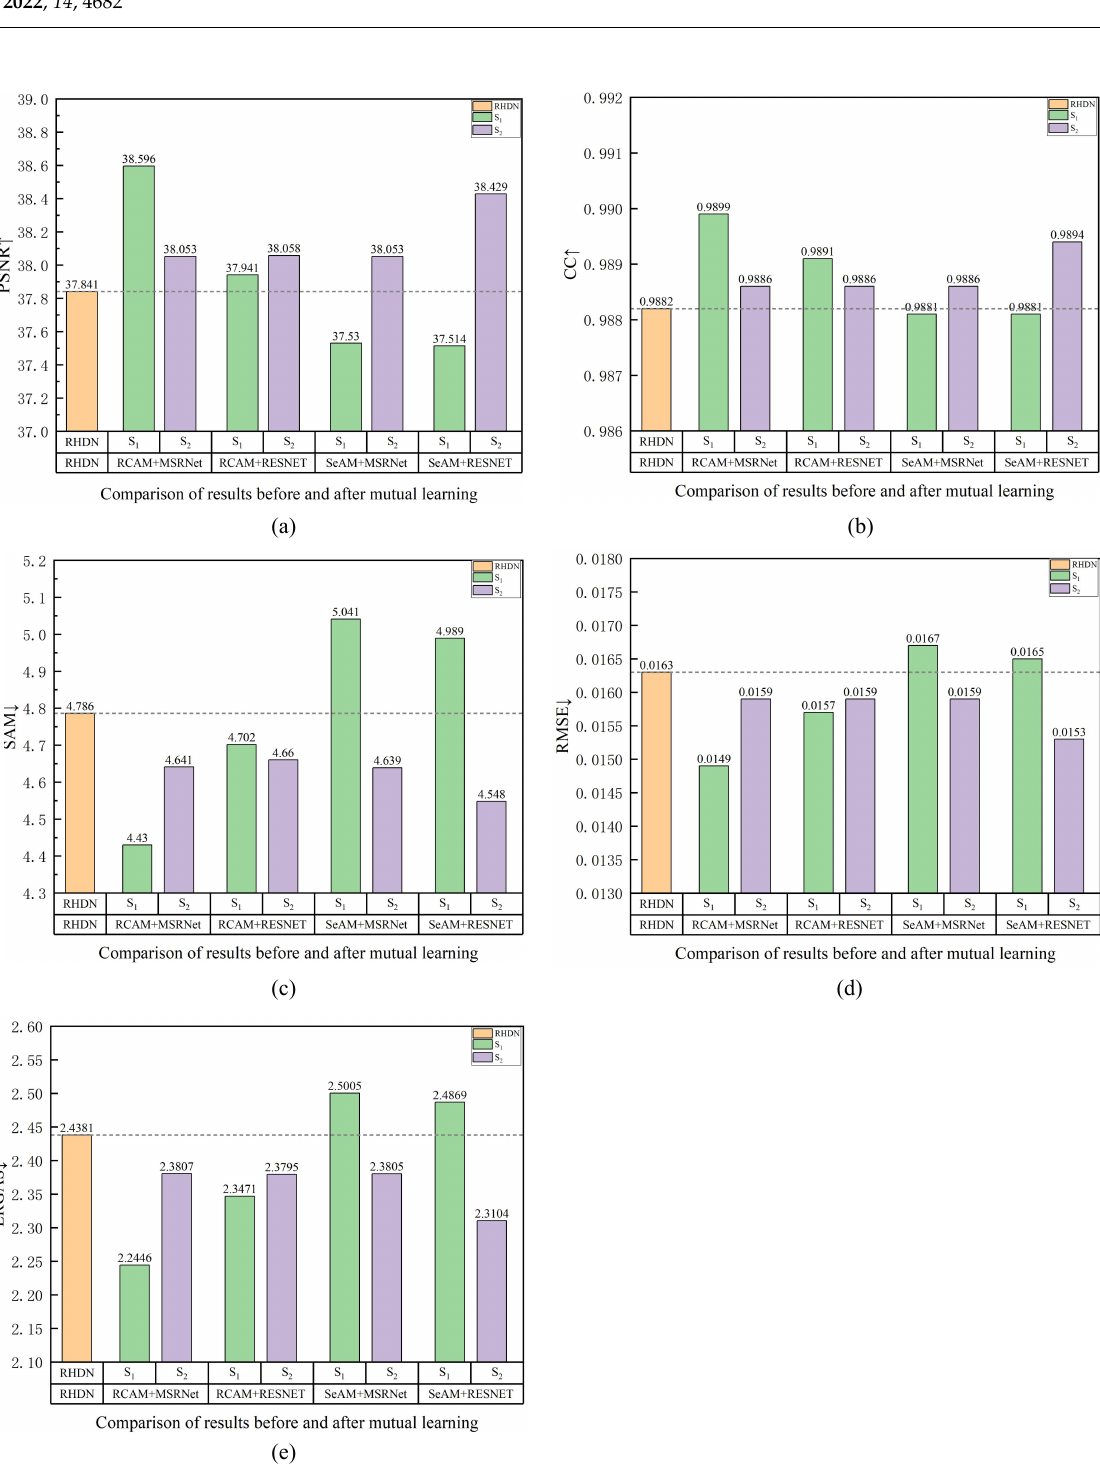
Figure 9. Quality evaluation for the comparison of results before and after mutual learning. ( a ) PSNR; ( b ) CC; ( c ) SAM; ( d ) RMSE; ( e )